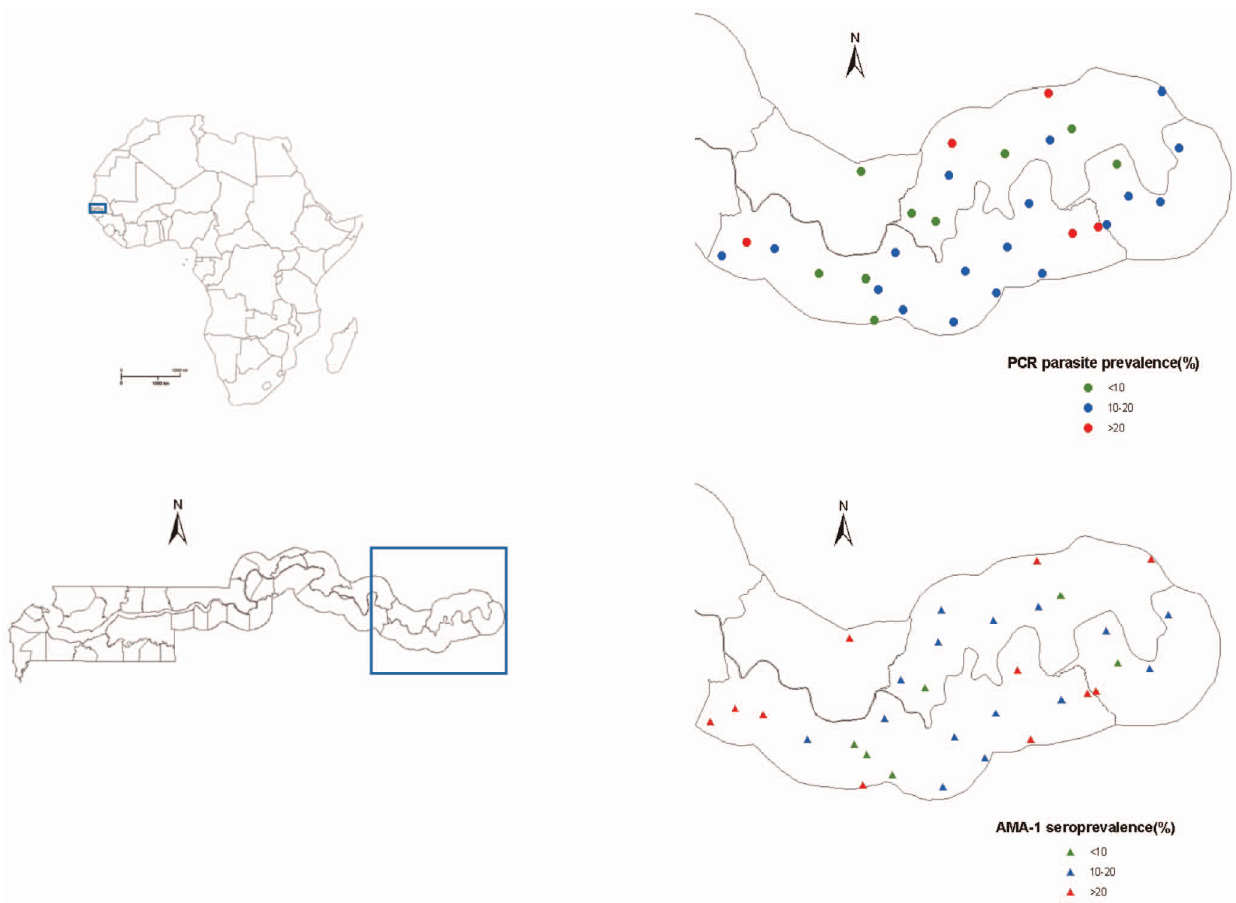
Figure 3. Parasite prevalence and seroprevalence by school.